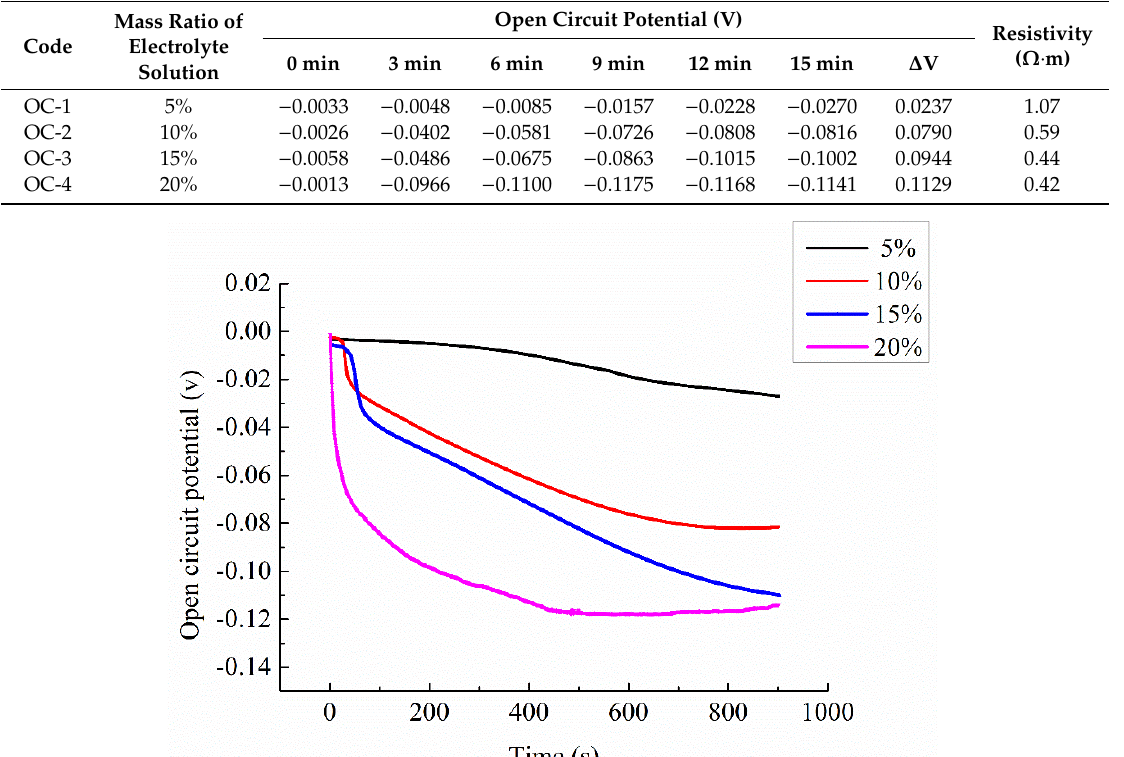
Table 7. Change of open circuit potential of specimens with different mass ratio electrolyte solution.